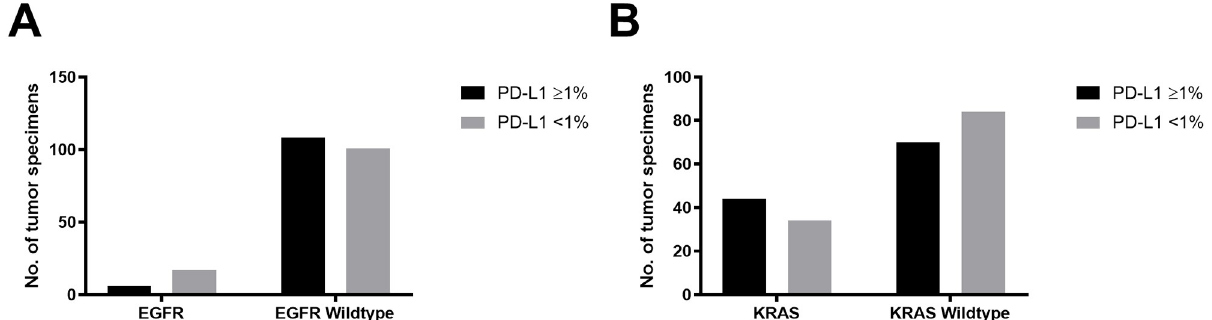
Fig 1. EGFR but not KRAS was negatively correlated with PD-L1 membranous protein expression in the lung cancer patient’s cohort. A total of 232 lung tumors were evaluated for PD-L1 expression on tumor cells. All patients were screened previously for molecular alterations. EGFR positive patients were shown to negatively correlated to PD-L1 (p = 0.02; Fisher exact test) 26% of EGFR+ patients had PD-L1 expression versus 74% had PD-L1 expression in the same population.